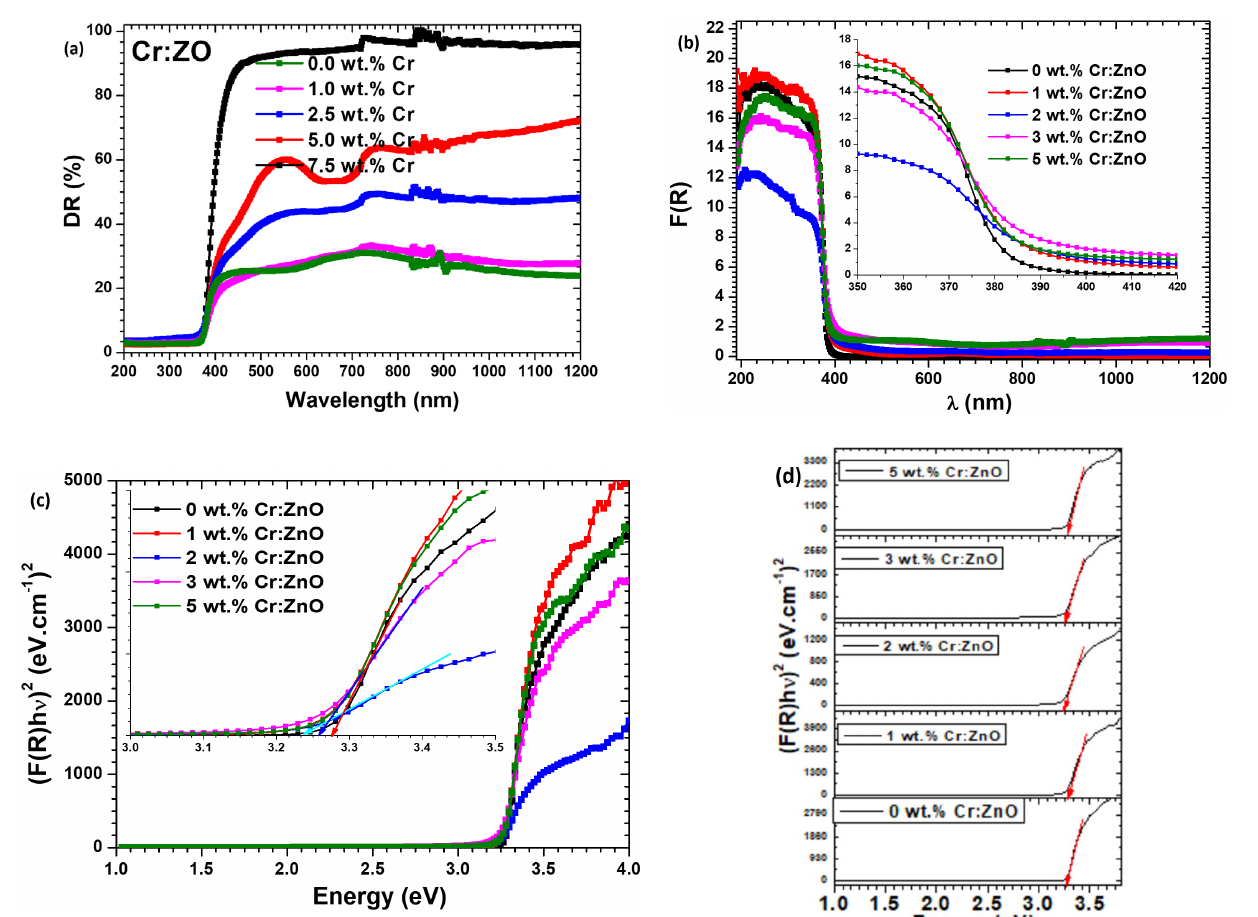
Figure 4. ( a ) DR, ( b ) Kubelka–Munk function, ( c ) energy gap plots, and ( d ) band gap plots separately for pure and Cr-doped ZnO NPs.